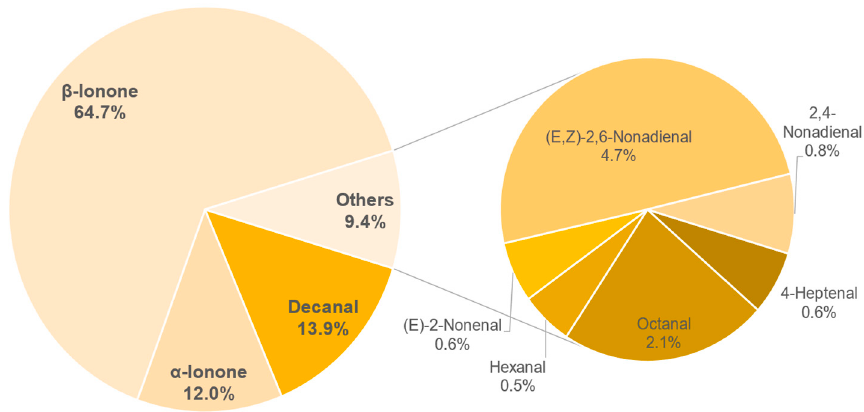
Figure 16. Percentage of OAV of each compound in the total aroma of sample 234.